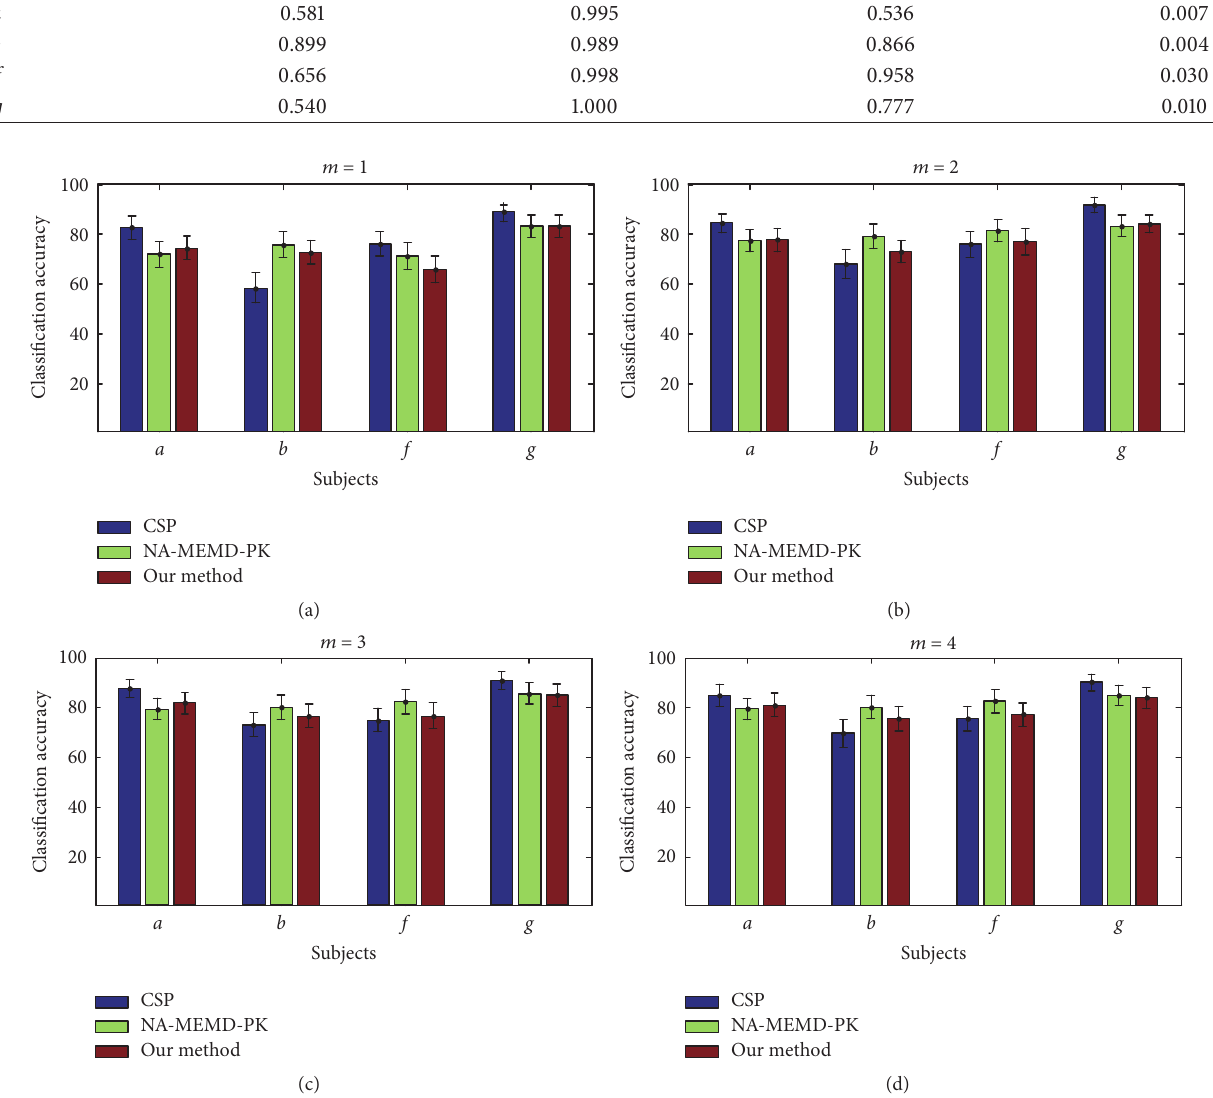
Figure 7: Classification accuracies (mean and standard deviation) obtained for the four subjects of BCI Competition IV Dataset I when 𝑚 = 1, 2, 3, 4 ,